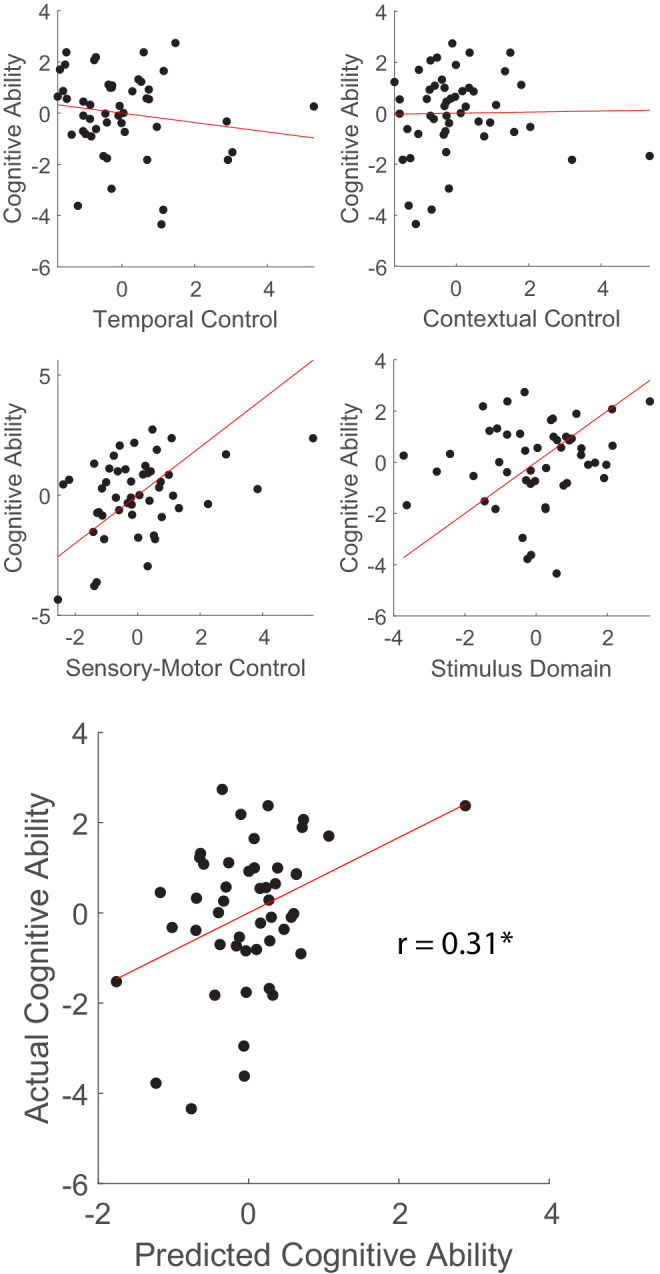
With reduced smoothing, activation-based measures remain significantly predictive of higher-level cognitive ability.